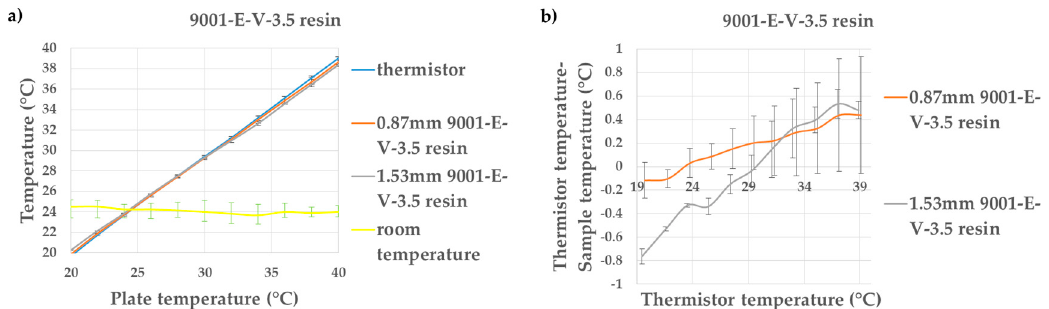
Figure 2. Thermistor samples encapsulated within resin micro-pods created with 9001-E-V-3.5. ( a ) The effect of increasing the plate temperature on the temperature recorded by the thermistor and the samples (0.87 mm 9001-E-V-3.5 resin and 1.53 mm 9001-E-V-3.5 resin); ( b ) The difference between the temperature recorded by the samples compared to the thermistor temperature, showing the deviations from the expected